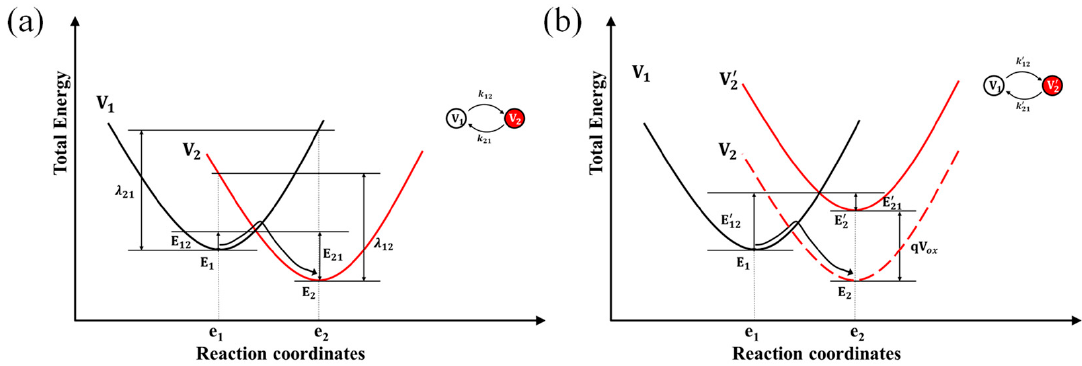
Figure 9. Relationship of total energy to reaction coordinate of nonradiative multiphonon transition process without electric field ( a ) and with an electric field ( b ). V 1 and V 2 represent the neutral state and negative charge state of the defect, respectively. V (cid:48) represents the negative charge state of defect 2 when an electric field is present. E 12 is the electron capture energy barrier, and E 21 is the electron emission energy barrier. The vibrational energy of the system is modeled by E 12 and E 21